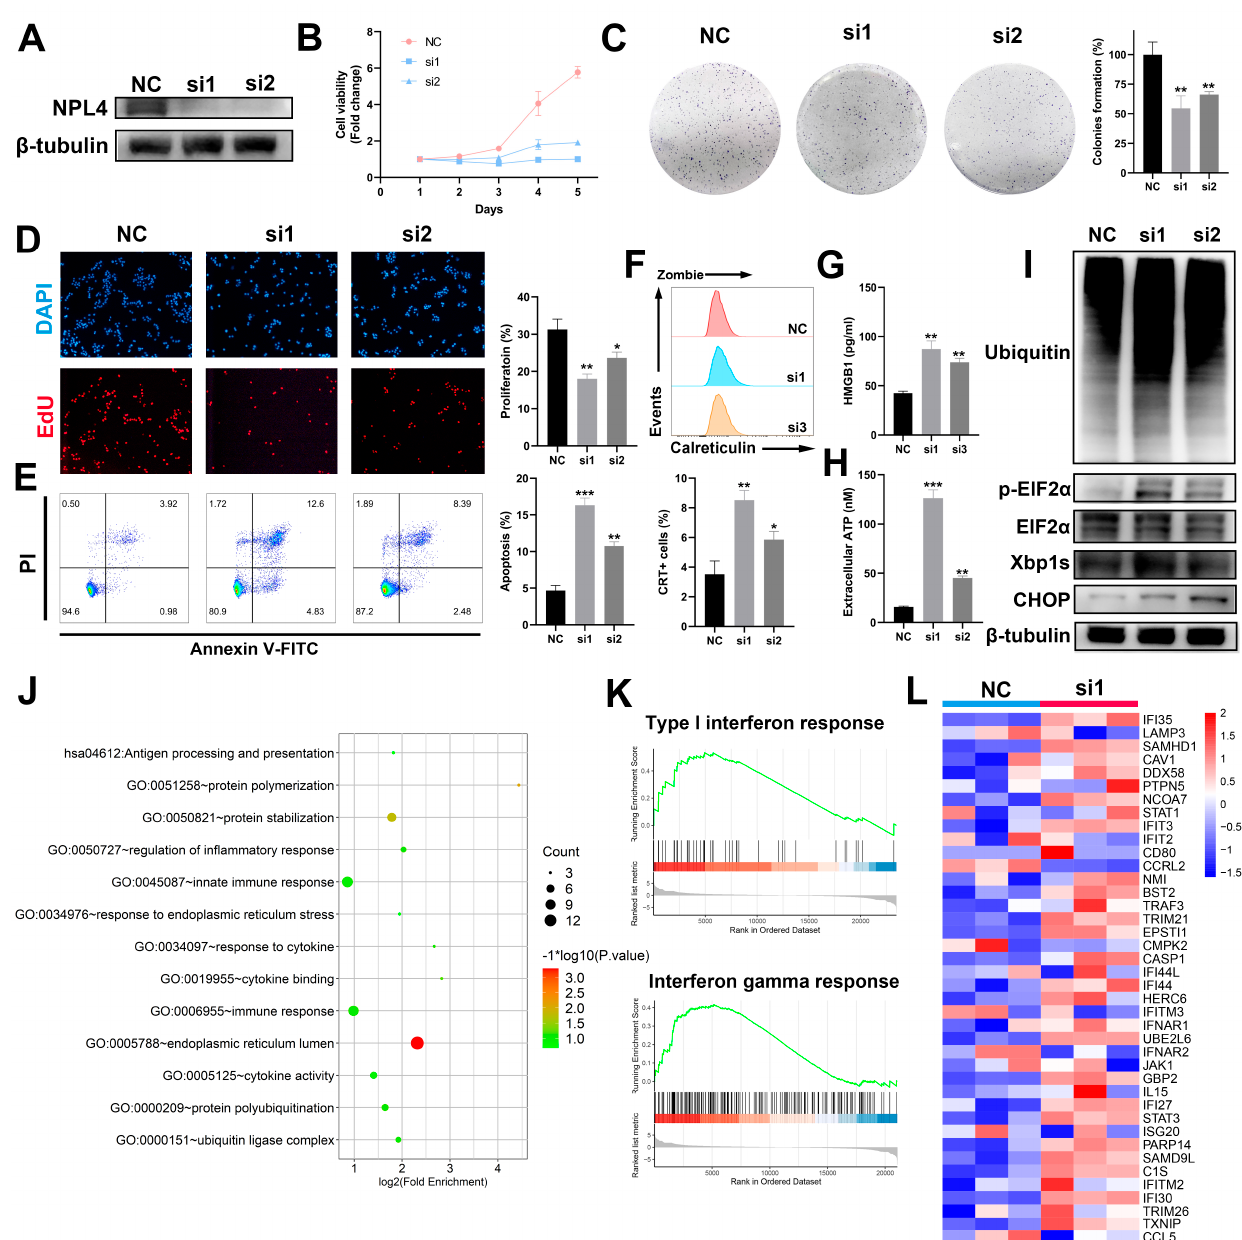
Figure 4. Inhibition of NPL4 inhibits proliferation and induces ICD in HCC cells. ( A ) Inhibition efficiency of NPL4 in LM3 cells through Western blot analysis. ( B ) The role of NPL4 inhibition in cell viability was detected by CCK-8 assay. ( C ) The role of NPL4 inhibition in clone-forming capacity of LM3 cells. ( D ) The role of NPL4 inhibition in cell proliferation was detected by Edu assay. Images with magnification at 100× are shown here. ( E ) Apoptosis analysis of LM3 cells after NPL4 inhibition. ( F ) CRT exposure, ( G ) HMGB1 release, and ( H ) ATP secretion of LM3 cells after NPL4 inhibition. ( I ) Western blot analysis of unfolded protein response and poly-ubiquitylated proteins in LM3 cells after NPL4 inhibition. ( J ) Pathway analysis of LM3 cells after NPL4 inhibition. ( K ) Gene-set enrichment analysis of type Ⅰ interferon response- and interferon-gamma response-related genes in LM3 cells after NPL4 inhibition. ( L ) Heatmap of type Ⅰ interferon response-related genes in LM3 cells after NPL4 inhibition. *: p < 0.05; **, p < 0.01; ***, p < 0.001 . The uncropped blots are shown in Figure S6.